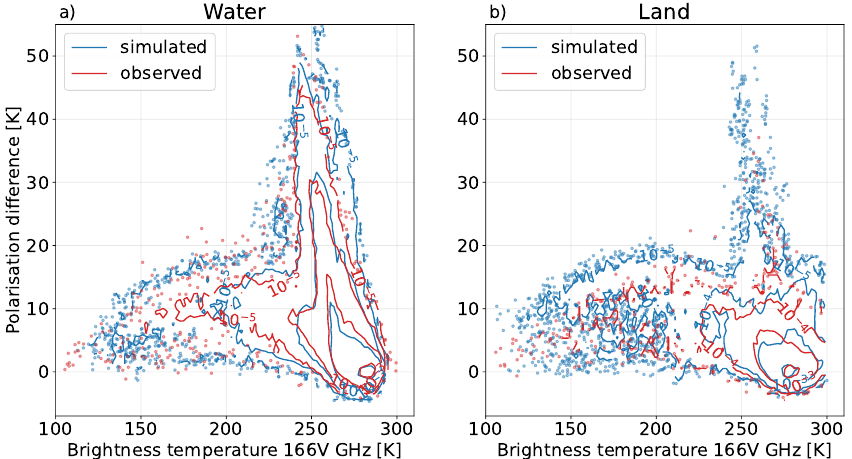
Figure 4. The polarisation differences (166V − 166H) as a function of TB 166V GHz for observed (red) and simulated (blue) values for water ( a ) and land ( b ). The PDs are plotted as contours of the normalised 2D histogram. Data with a bin density of less than 10 − 5 are also shown as dots. The polarisation effects from the surface are included. The simulations and observations were from January 2009 and January 2017, respectively.